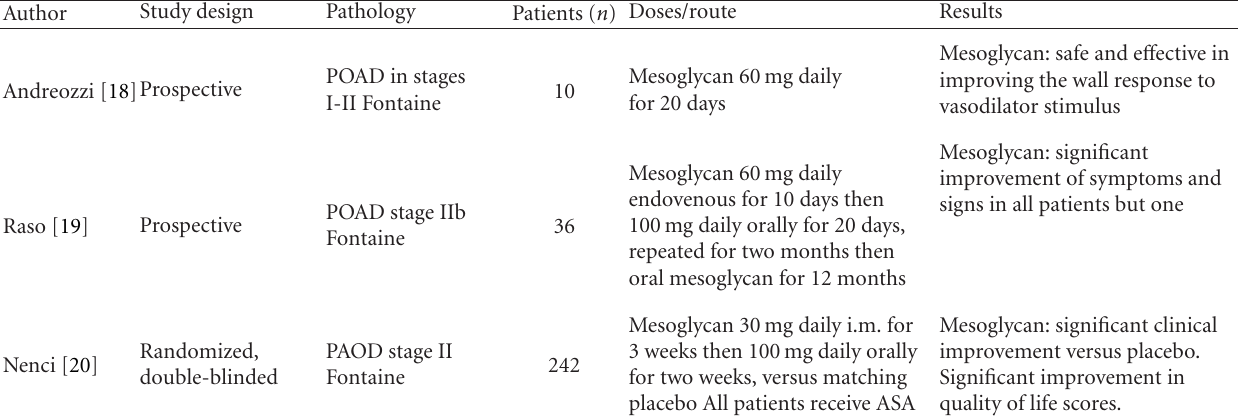
Table 2: Mesoglycan in peripheral obstructive arterial disease (POAD). Clinical